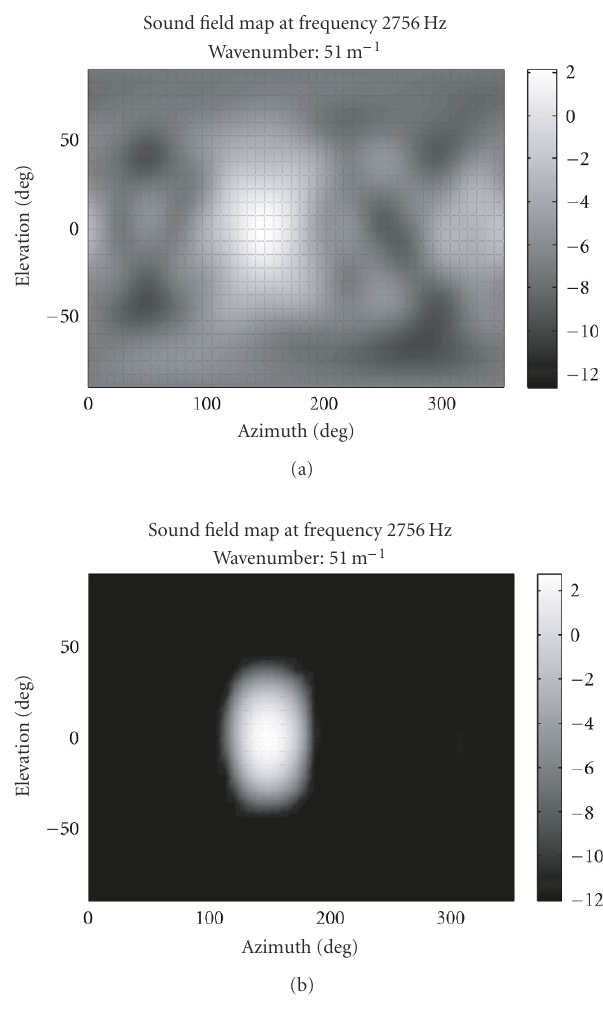
Figure 5: Sound field cartographies for a point source located at [ r = 1m, az = 148dg, el = 0dg], at frequency 2756 Hz, using uniform tap vectors (top) or optimal tap vectors